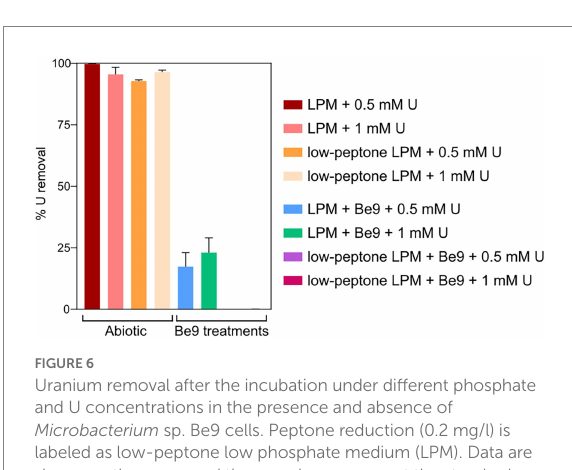
FIGURE 6 Uranium removal after the incubation under different phosphate and U concentrations in the presence and absence of Microbacterium sp. Be9 cells. Peptone reduction (0.2 mg/l) is labeled as low-peptone low phosphate medium (LPM). Data are shown as the mean and the error bars represent the standard error of at least three independent measurements.